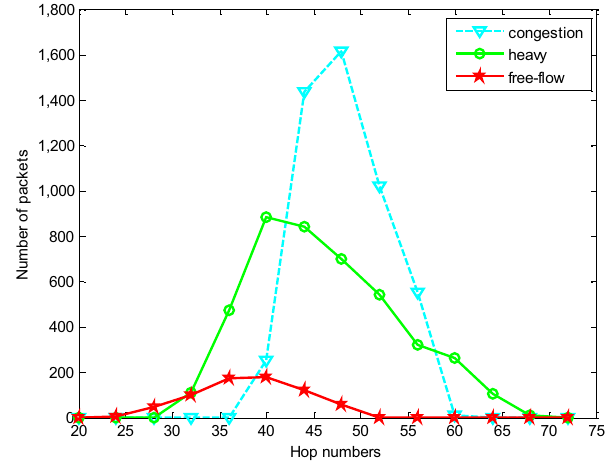
Figure 8 Relationship between the number of copies and the number of relays for different traf fi c